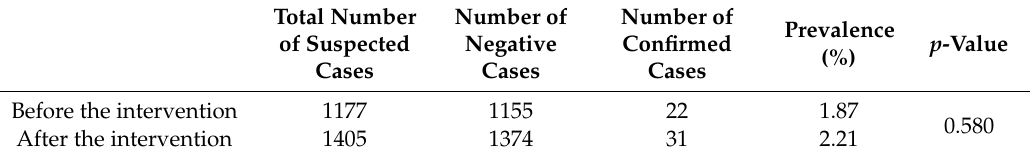
Table 3. Comparison of the Number of HAT Cases Before and After 6 Months of